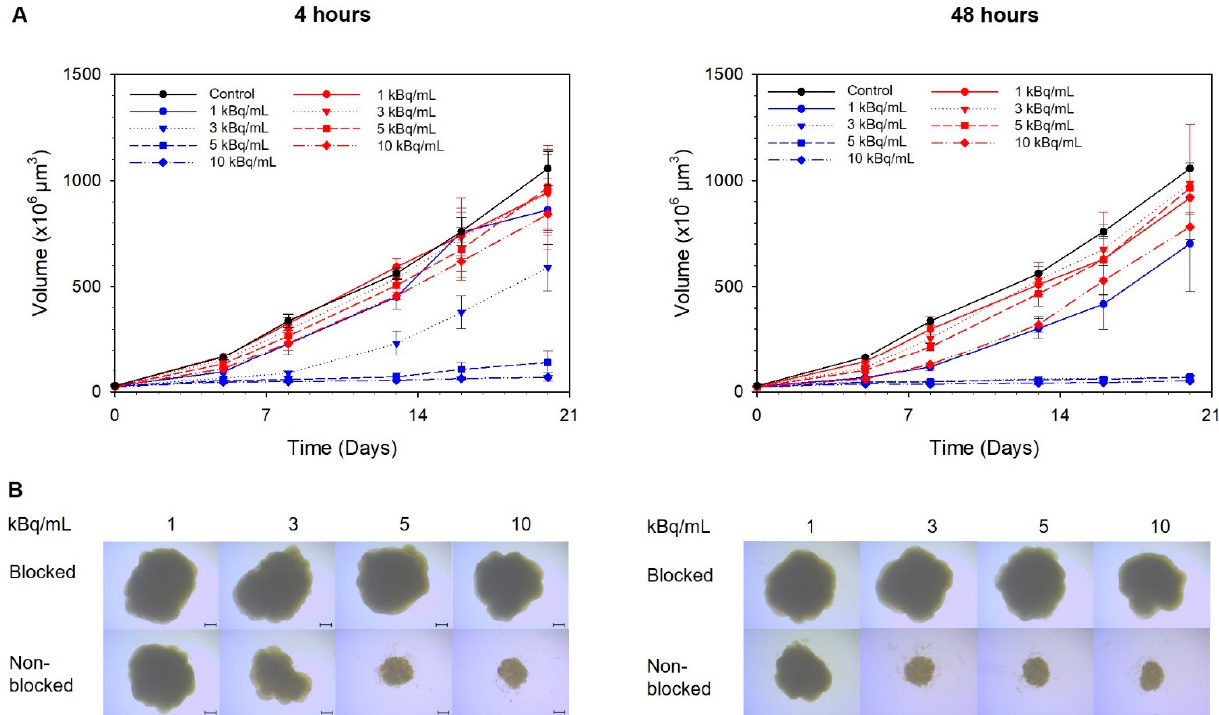
Figure 1. The influence of 212 Pb-NG001 on C4-2 spheroid growth after incubation for 4 (left) or 48 (right) h at 37 °C. ( A ) Growth of spheroids in the nonblocked 212 Pb-NG001 (blue), blocked 212 Pb-NG001 (red) and control (black) groups was measured for up to 20 days and is presented as volume (×10 6 µm 3 ) ± SD (one experiment, N = 6 spheroids per group). The blocked group was preblocked with an excess of unlabelled NG001 to occupy PSMA binding sites. ( B ) Microscope images (×4 magnification) were taken at the predefined study end point of 20 days using a bright-field microscope with AxioVision Rel. 4.8 software; scale bars are 200 µm.